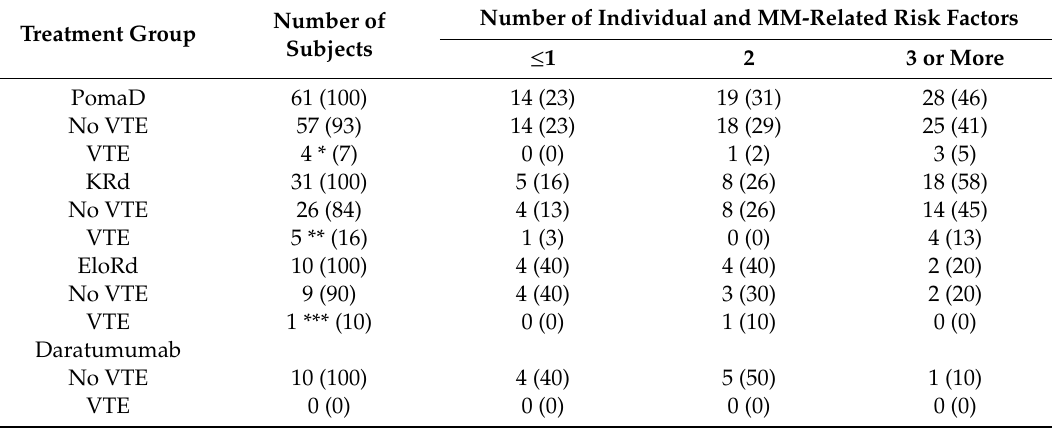
Figure 2. Distribution of VTE among RRMM patients treated with novel agents as part of their second salvage regimen. Table 3. Analysis of risk factors for VTE among RRMM patients treated with novel